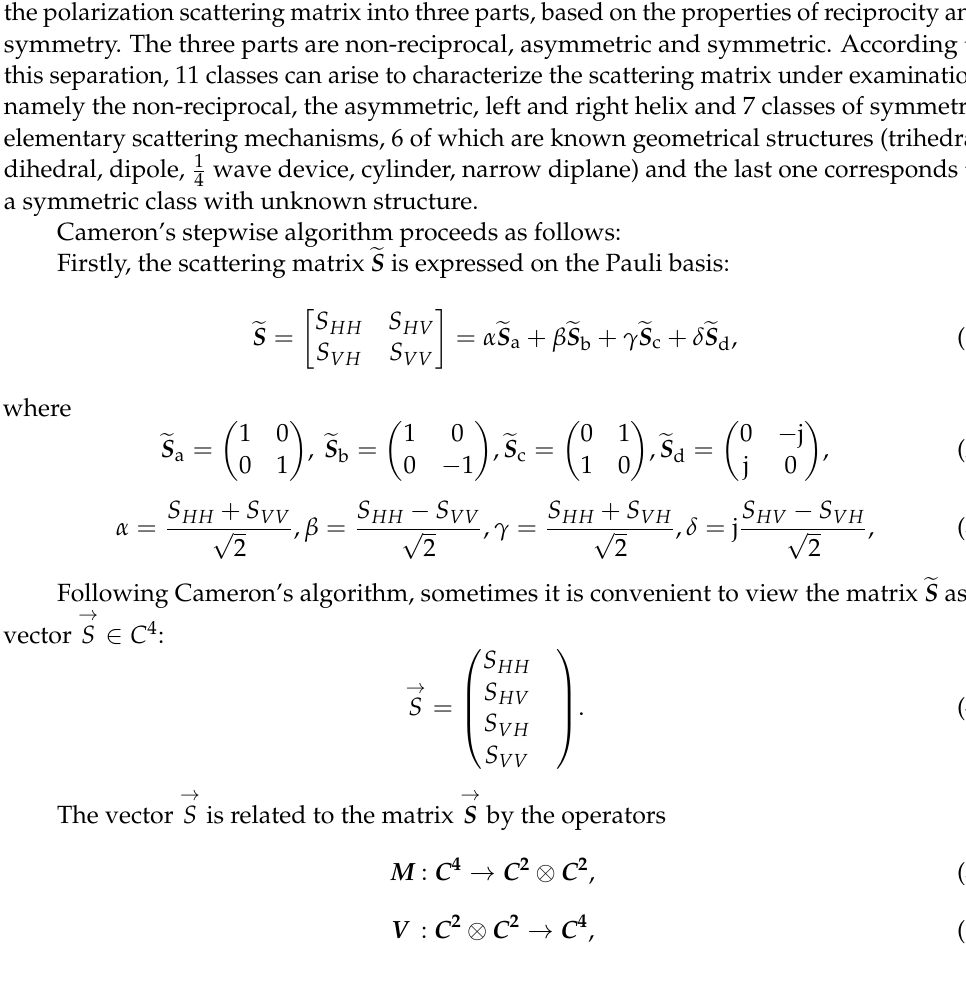
Figure 2. Broader area of Vancouver, by Google Earth. Sea land cover is blue, urban/built up area is red, suburban area is orange, dense vegetation is green and agriculture/pasture is beige.